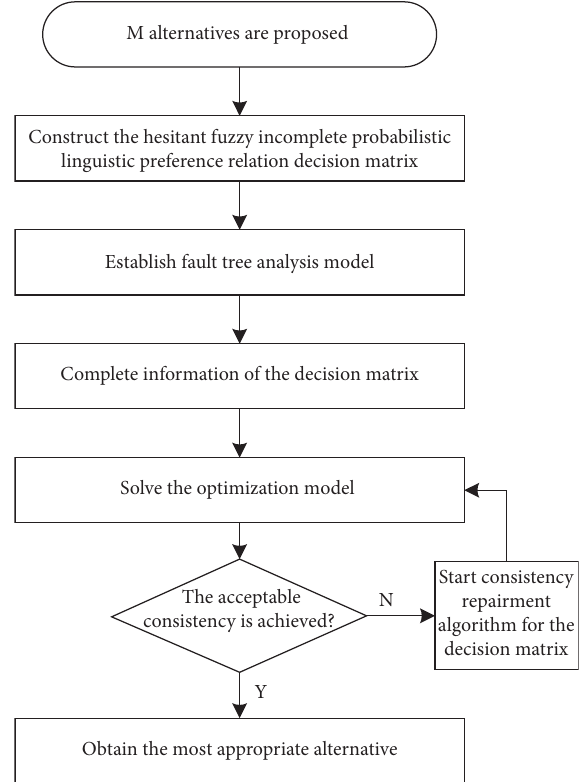
Figure 2: The main flowchart of the decision-making